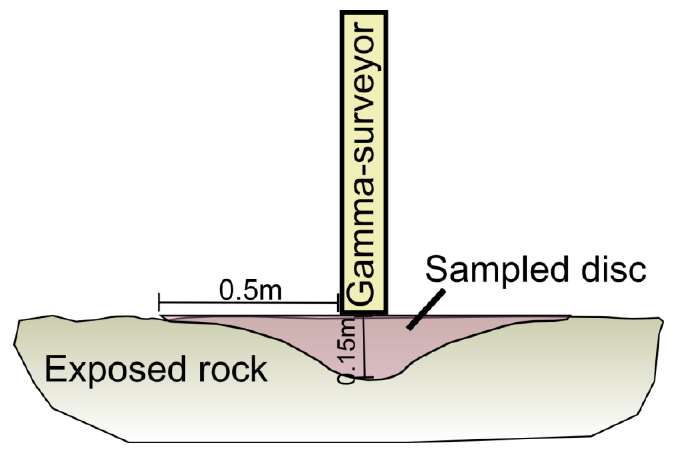
Figure 1. Schematic showing approximate areas of rock sampled by portable gamma surveyor placed on rock